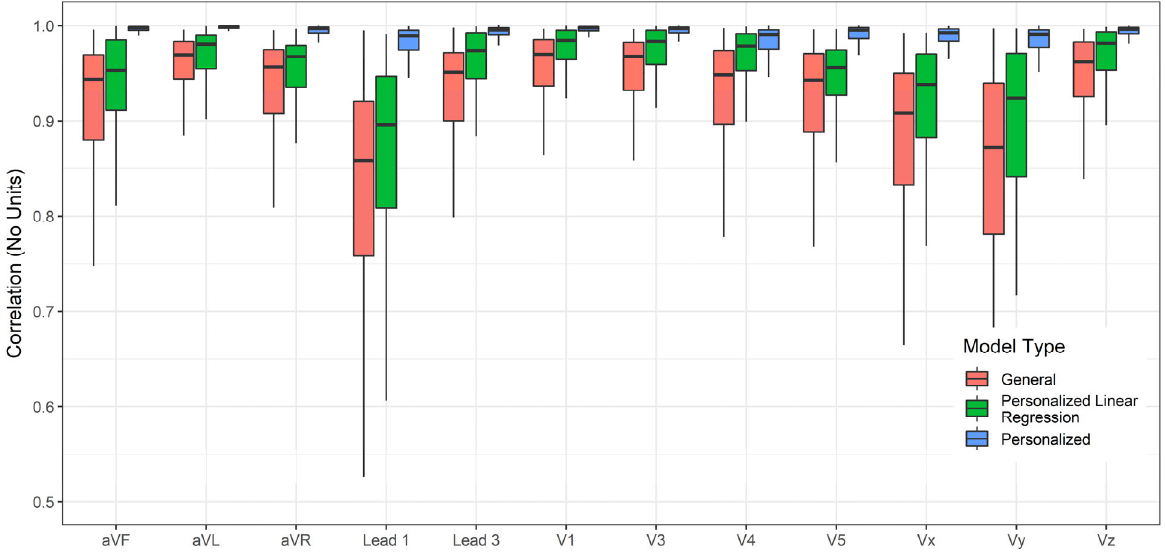
Figure 6. Compare the Pearson Correlation Coefficient of each derived channel between a GM-ECG, personalized linear regression, and PM-ECG for Lead II, V2, and V6 to all other leads transformation model.